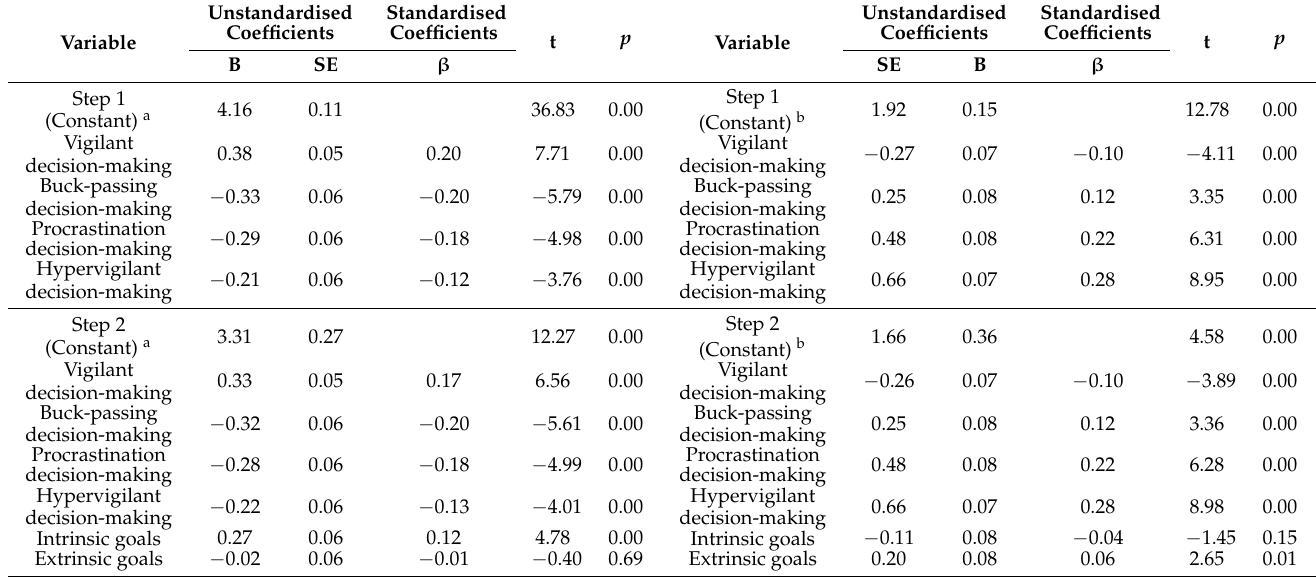
Table 6. Hierarchical regression analyses for Competence Satisfaction a and Frustration b